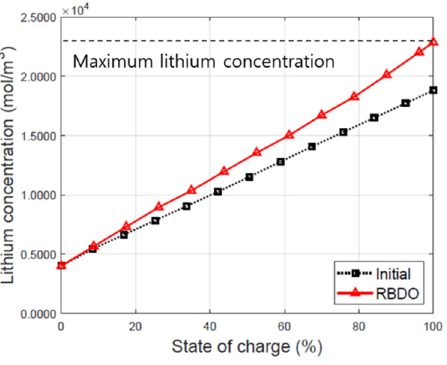
Figure 7. Lithium concentration of the cathode in the initial and optimized designs during dis-